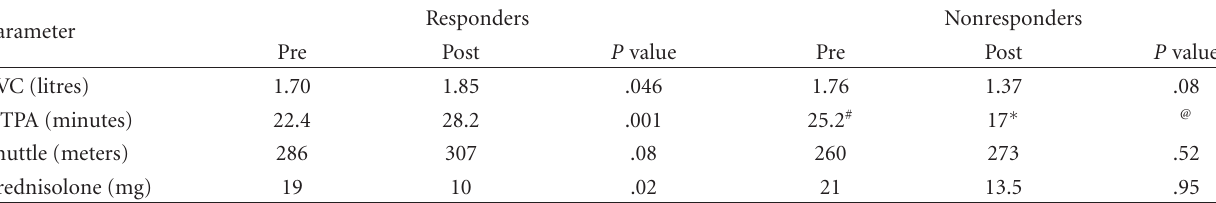
Table 2: Summary of the non-responders ( n = 5) and responders ( n = 9) before and after Ganciclovir. Comparison by paired t -test.